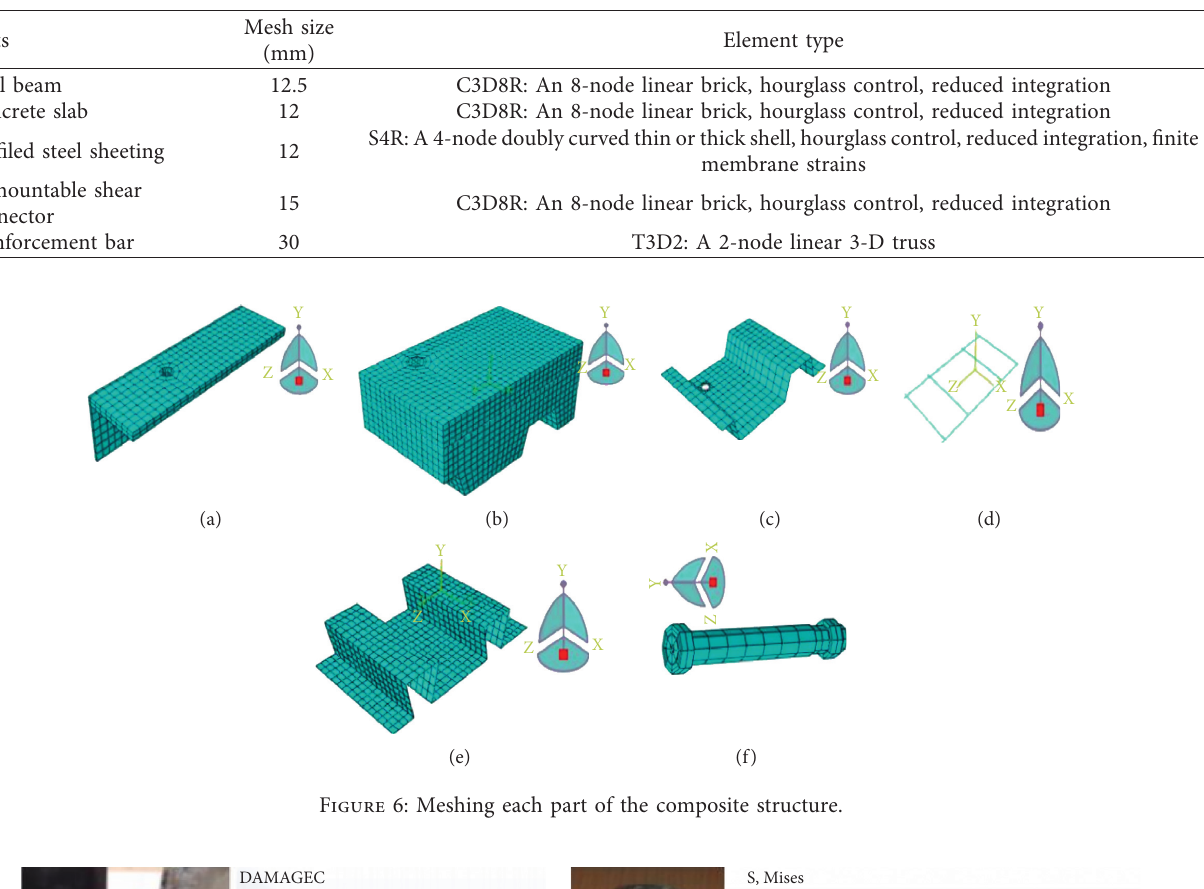
Table 3: Meshing size and element types for all parts in the